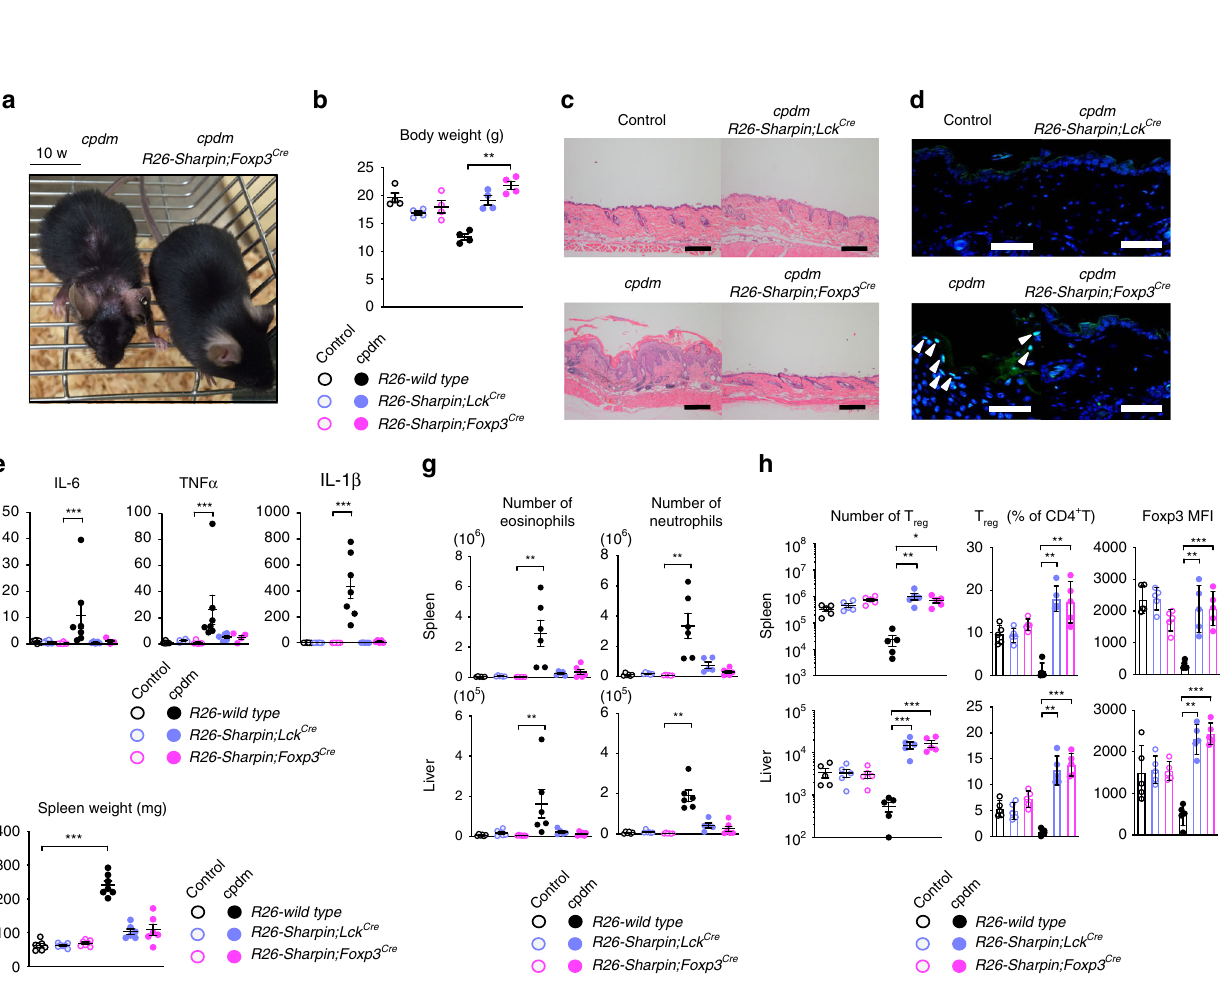
Fig. 3 Genetic compensation of Sharpin in T lineages rescues cpdm mice from autoin fl ammatory skin disease. a Representative appearance of 10-week-old cpdm and cpdm R26-Sharpin;Foxp3 Cre mice. b Body weight of indicated 10 – 12-week-old mice. n = 4 biologically independent animals. c , d Representative skin sections from the indicated 12-week-old mice. Scale bars: 200 μ m for H/E ( c ) and 50 μ m for TUNEL staining ( d ). TUNEL-positive epidermal cells are indicated as arrowheads. e Quantitative analyses of mRNAs encoding in fl ammation-related cytokines in the skin of 10 – 12-week-old mice. f Spleen weight from the indicated 10 – 12-week-old mice. n = 7 biologically independent animals. g Absolute number of eosinophils (CD11b + Gr1 + SiglecF + ) and neutrophils (CD11b + Gr1 hi ) in the spleen (upper) and liver (lower). n = 6 biologically independent animals. h Absolute number and percentage of Treg, and MFI of Foxp3 in Treg, in the spleen and liver of 10 – 12-week-old mice. n = 5 biologically independent animals. Data are representative of two independent experiments ( c , d ) or pooled from three independent experiments ( b , e – h ). Small circles indicate individual mice. Small horizontal lines indicate the mean (± s.e.m.). * p < 0.05, ** p < 0.01, *** p < 0.001. Kruskal-Wallis test with Bonferroni correction ( α value = 0.05) was used for b , e – h . Also, see Supplementary Fig. 3. Source data are provided in a Source Data fi